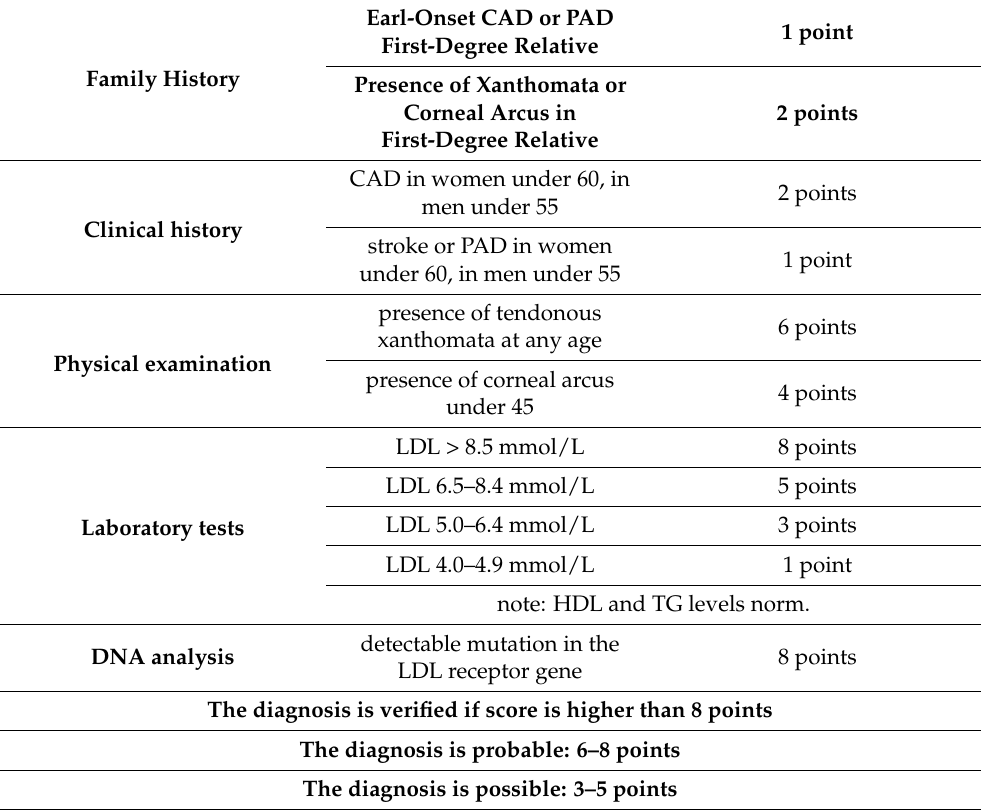
Table 2. Dutch Lipid Clinic Network diagnostic criteria